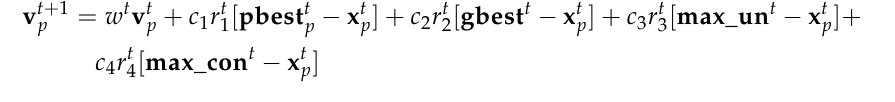
Algorithm 1: Enhanced GP-based PSO